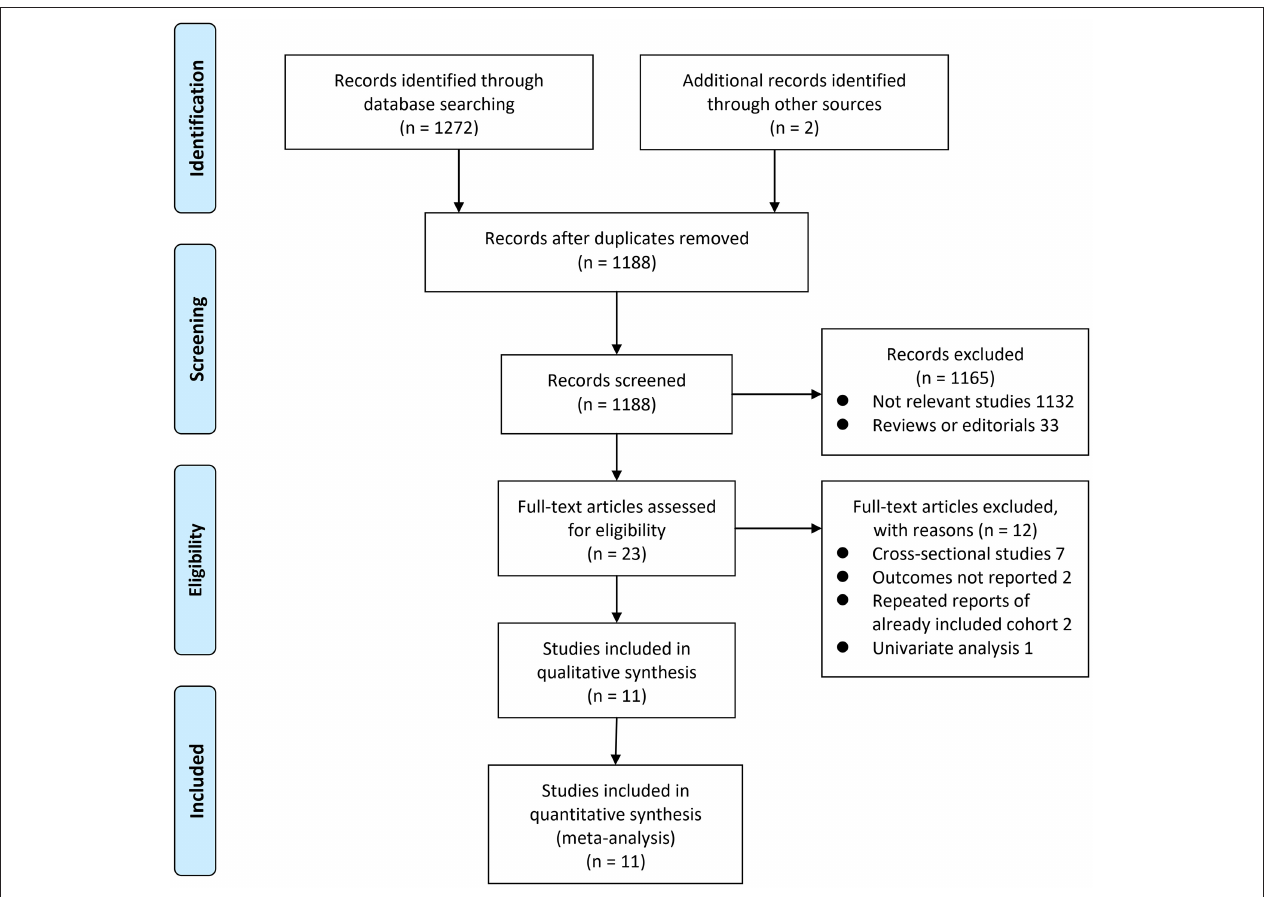
FIGURE 1 | Flowchart of database search and study